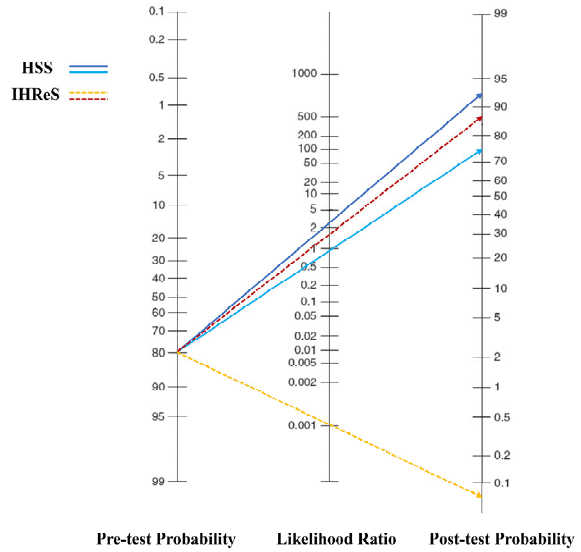
Figure 1. ROC comparison between the HSS and the IHReS.